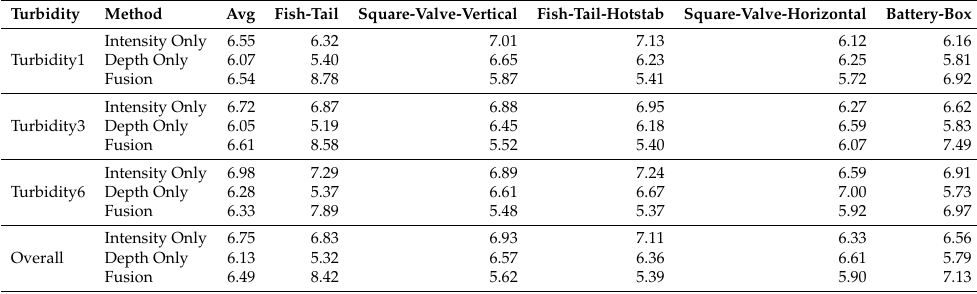
Table 3. Per class translation error (RTE) in cm for the test dataset. The results are averaged over all acquisition.